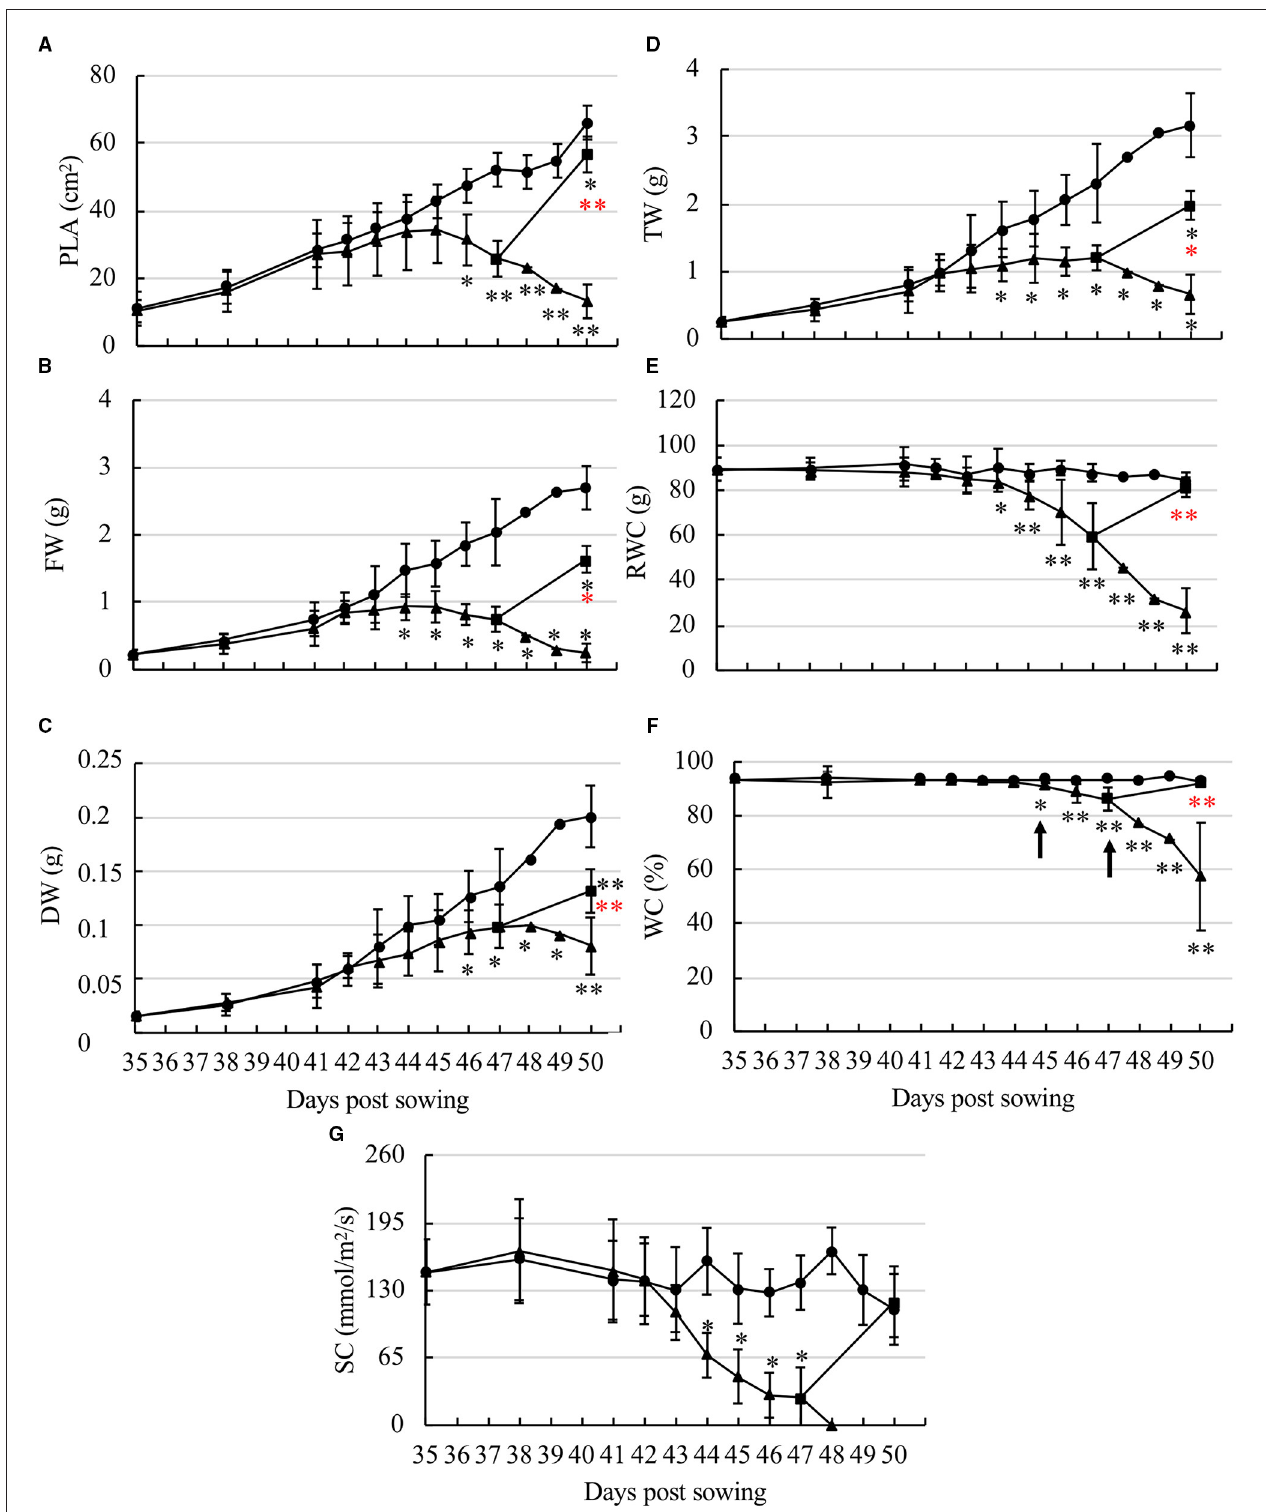
FIGURE 2 | Characterization of the effect of water deficit of Col-0 A. thaliana leaves. (A) PLA, projected leaf area; (B) FW, fresh weight; (C) DW, dry weight; (D) TW, turgid weight; (E) RWC, relative water content; (F) WC, water content; (G) SC, stomatal conductance, were measured under WW (circle), WD (triangle), and RW (square). The study was carried out with five plants per condition, and three independent biological repeats were performed ( ± SD). Statistical analysis was performed using the Mann–Whitney pairwise comparison test (* p < 0.05, ** p < 0.001). The WD values that are significantly different in comparison to WW are indicated by a black asterisk and the WD values that are significantly different in comparison to WD are indicated by a red aster.